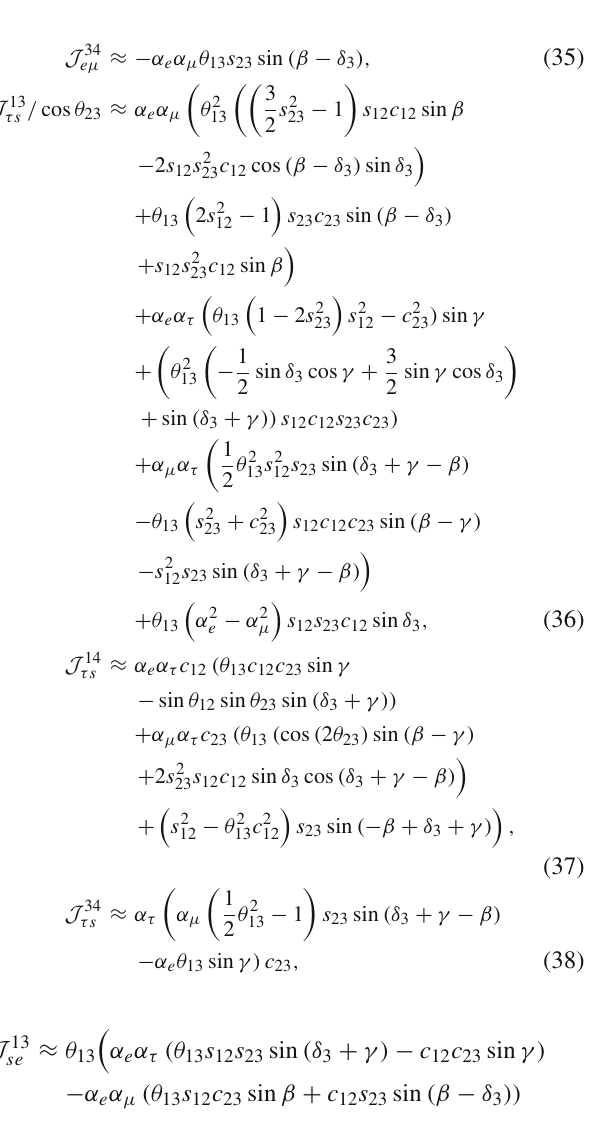
Fig. 6 Jarslkog rephasing invariant J 23 e μ as a function of the smallest neutrino mass for both